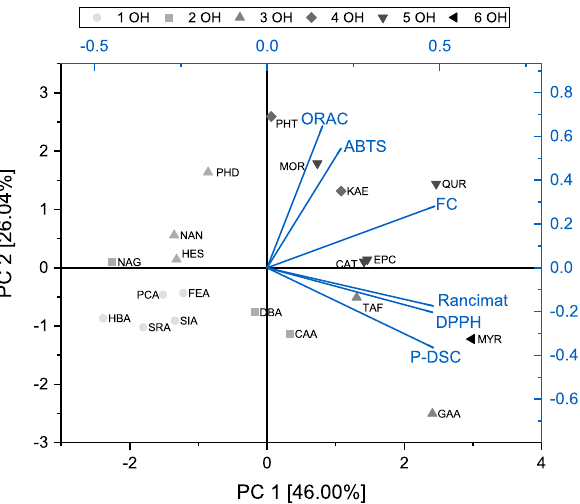
Figure 2. PC analysis of results from Rancimat and the P-DSC, ABTS, DPPH, FC, and ORAC assays presented in dependence of number of hydroxyl groups.